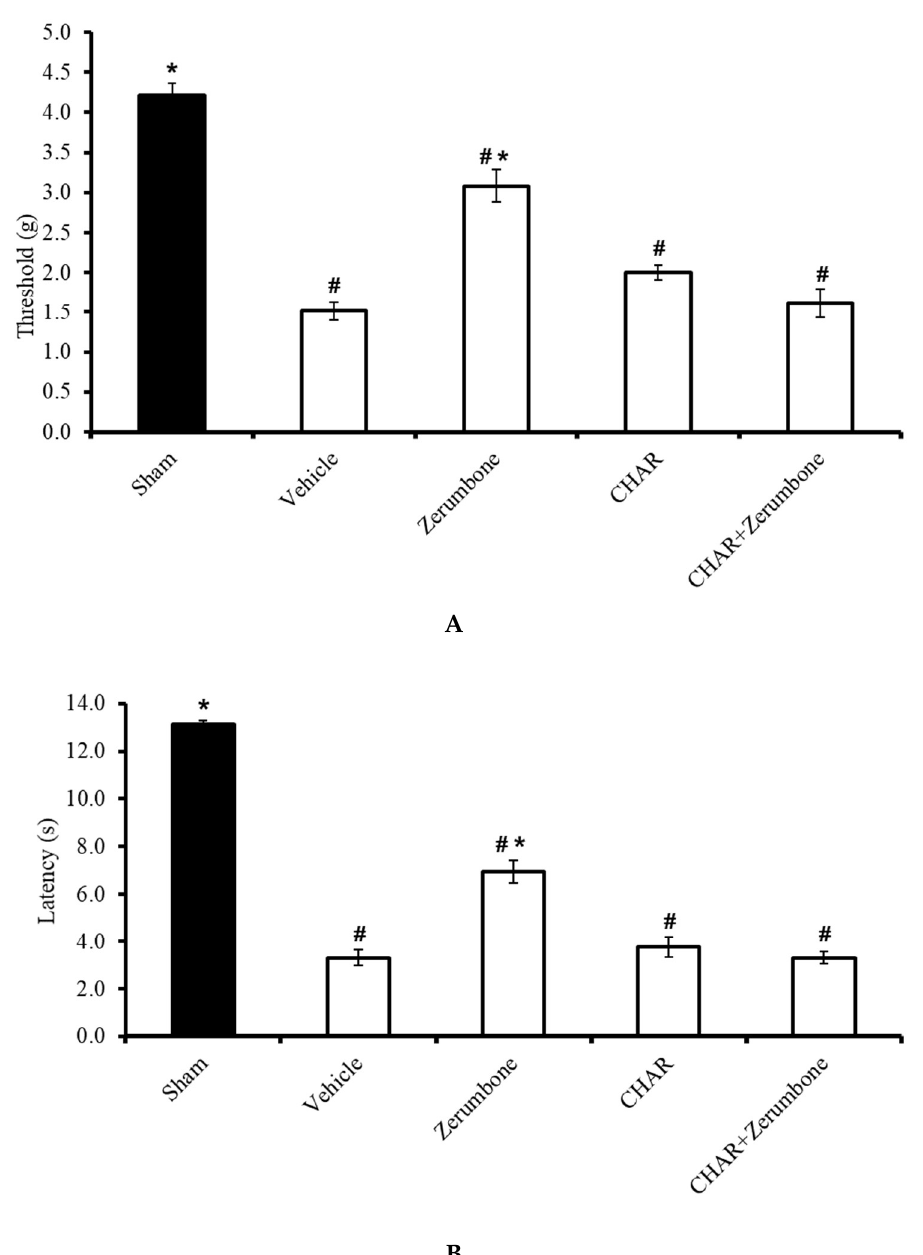
Figure 4. Effect of zerumbone (10 mg/kg; i.p.) and pre-treatment with a large-conductance Ca 2+ -activated K + channel inhibitor (charybdotoxin, CHAR; 0.02 mg/kg; i.p.) on the responses toward ( A ) mechanical allodynia and ( B ) thermal hyperalgesia on CCI-induced neuropathic pain in mice. Each column represents the mean ± SEM; n = 8 mice per group. Note: # significantly different ( p ≤ 0.05) than sham group; * significantly different ( p ≤ 0.05) than vehicle group (one-way ANOVA followed by Tukey’s post hoc test).